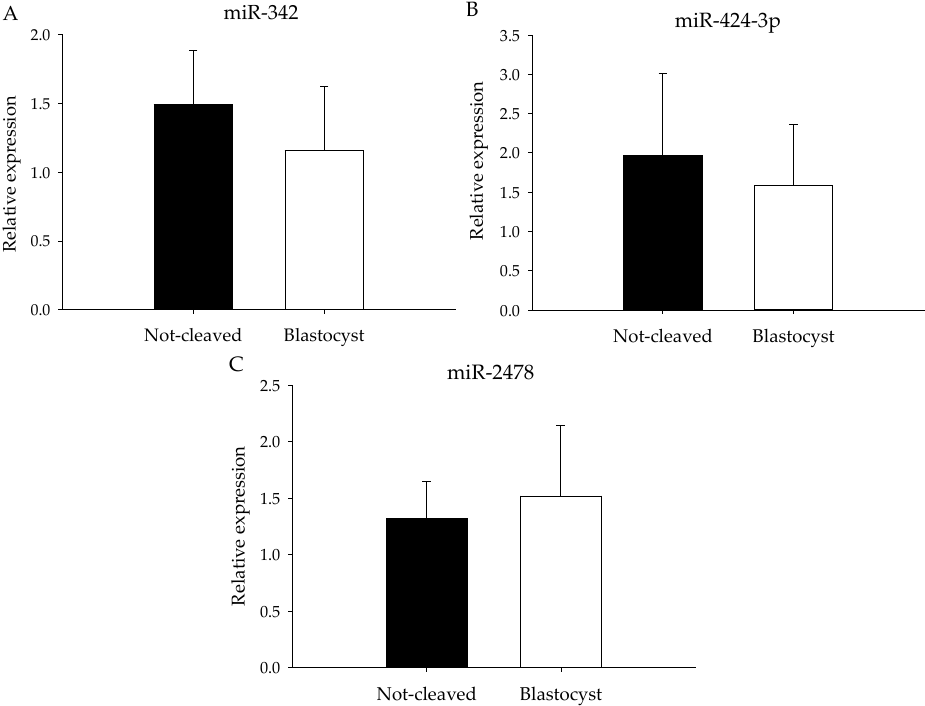
Figure 5. miRNA expression of pooled cumulus cell samples. Mean miRNA expression (qRT-PCR) for ( A ) miR-342, ( B ) miR-424-3p and ( C ) miR-2478 in pooled cumulus cell samples enclosing oocytes that failed to cleave (black bars) or that developed into blastocysts (white bars) after exposure to sperm. All samples were normalized for let-7a, miR-26a and miR-191 expression.